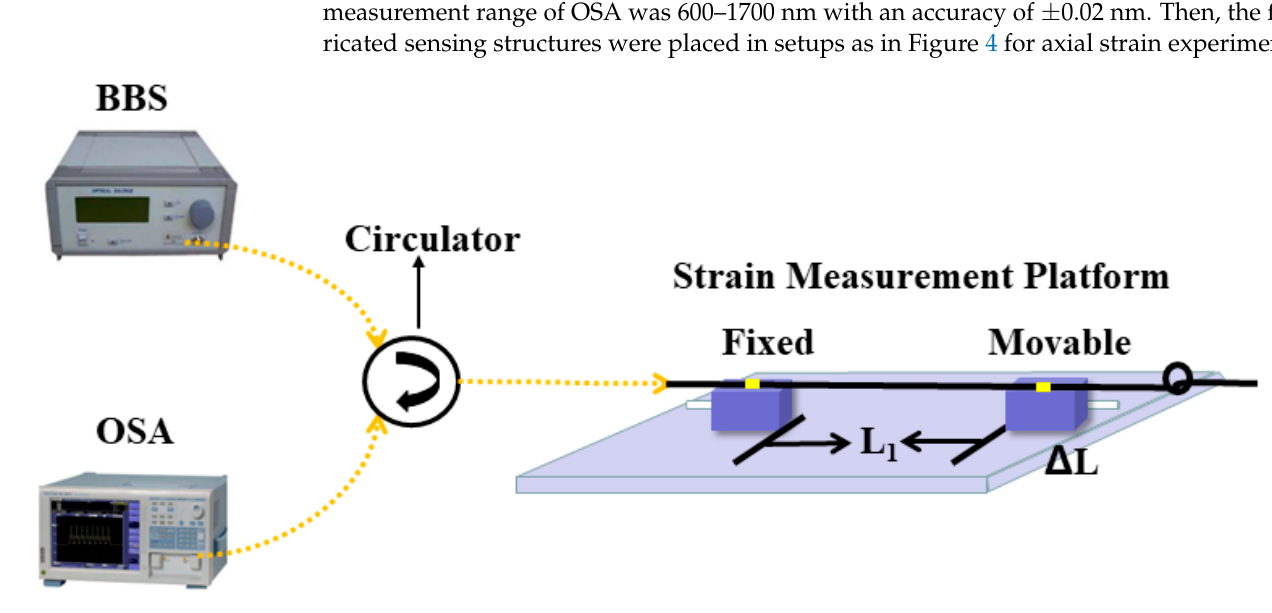
4. Experimental Results and Discussion